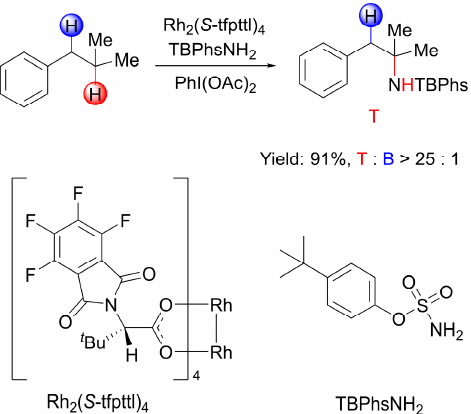
Figure 1. Rh 2 ( S -tfpttl) 4 -catalyzed intermolecular C( sp 3 ) − H amination of isobutylbenzene.